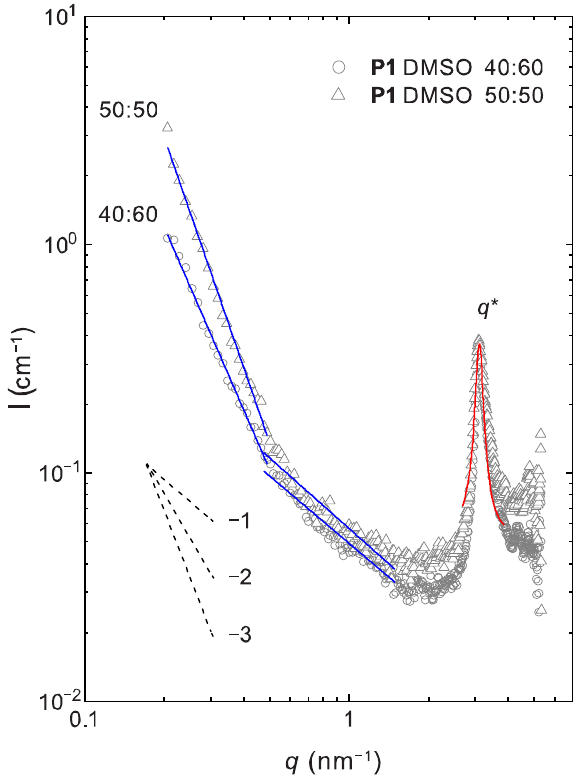
Figure 4. X-ray scattering patterns of polymer 1 in DMSO with polymer: solvent ratios 50:50 (trian- gles) and 40:60 (circles). Blue and red lines are fit to the power-law regions and to the interference maximum. Black dashed lines show q − 1 , q − 2 , and q − 3 slopes for comparison.